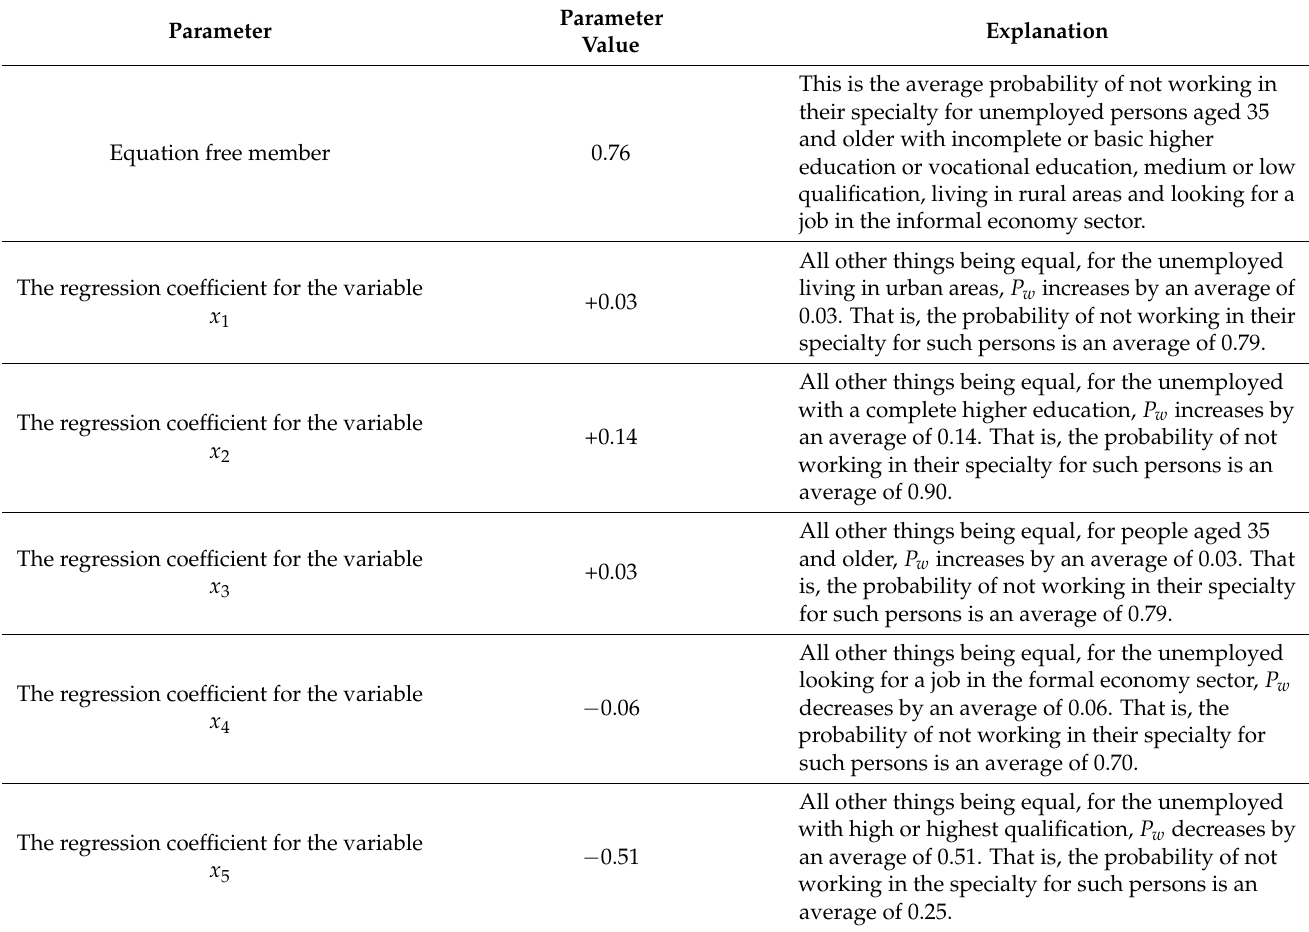
Table 2. Interpretation of model parameter values (author’s